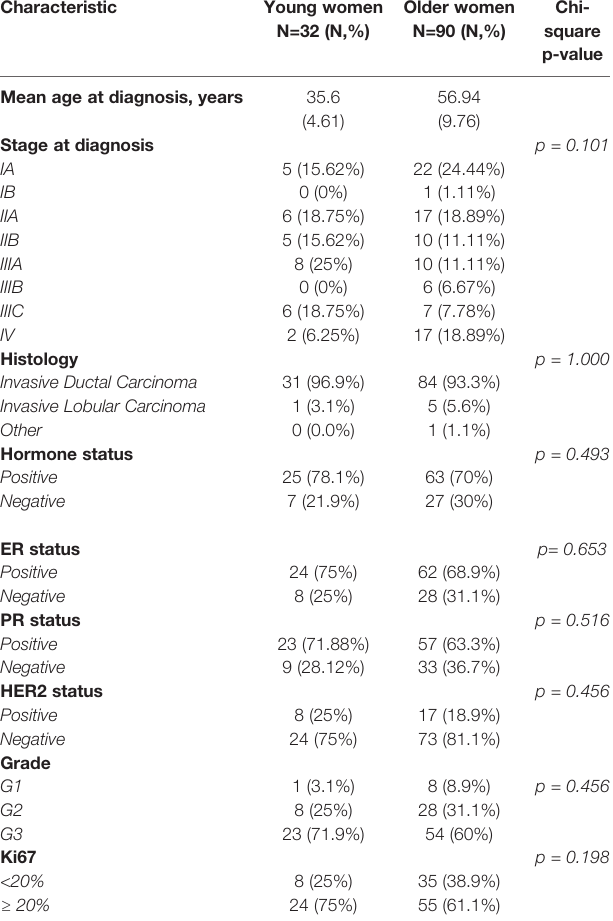
TABLE 1 | Clinicopathological characteristics of young (<40) and older (>40) women with breast cancer. Characteristic